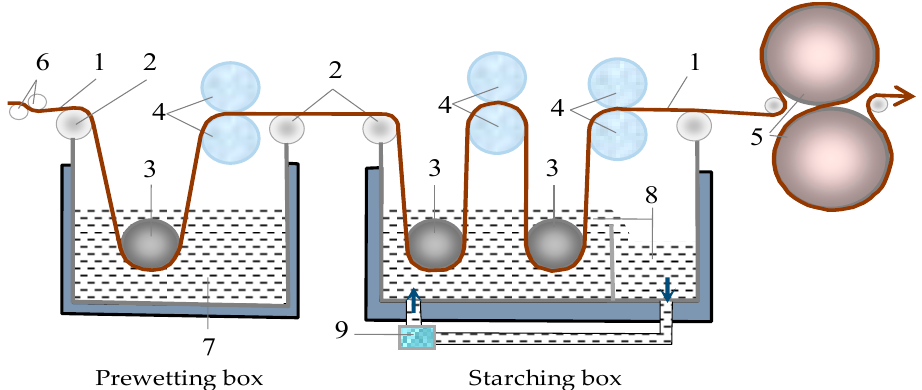
Figure 1. Scheme of a laboratory starching machine, where: 1—yarn, 2—rollers for guiding threads, 3—rollers for immersion in water and starch mass, 4—rollers for squeezing out excess water and starch mass, 5—rollers for contact drying, 6—tensiometer, 7—hot prewetting water, 8—starch mass, 9—starch mass circulation pump.